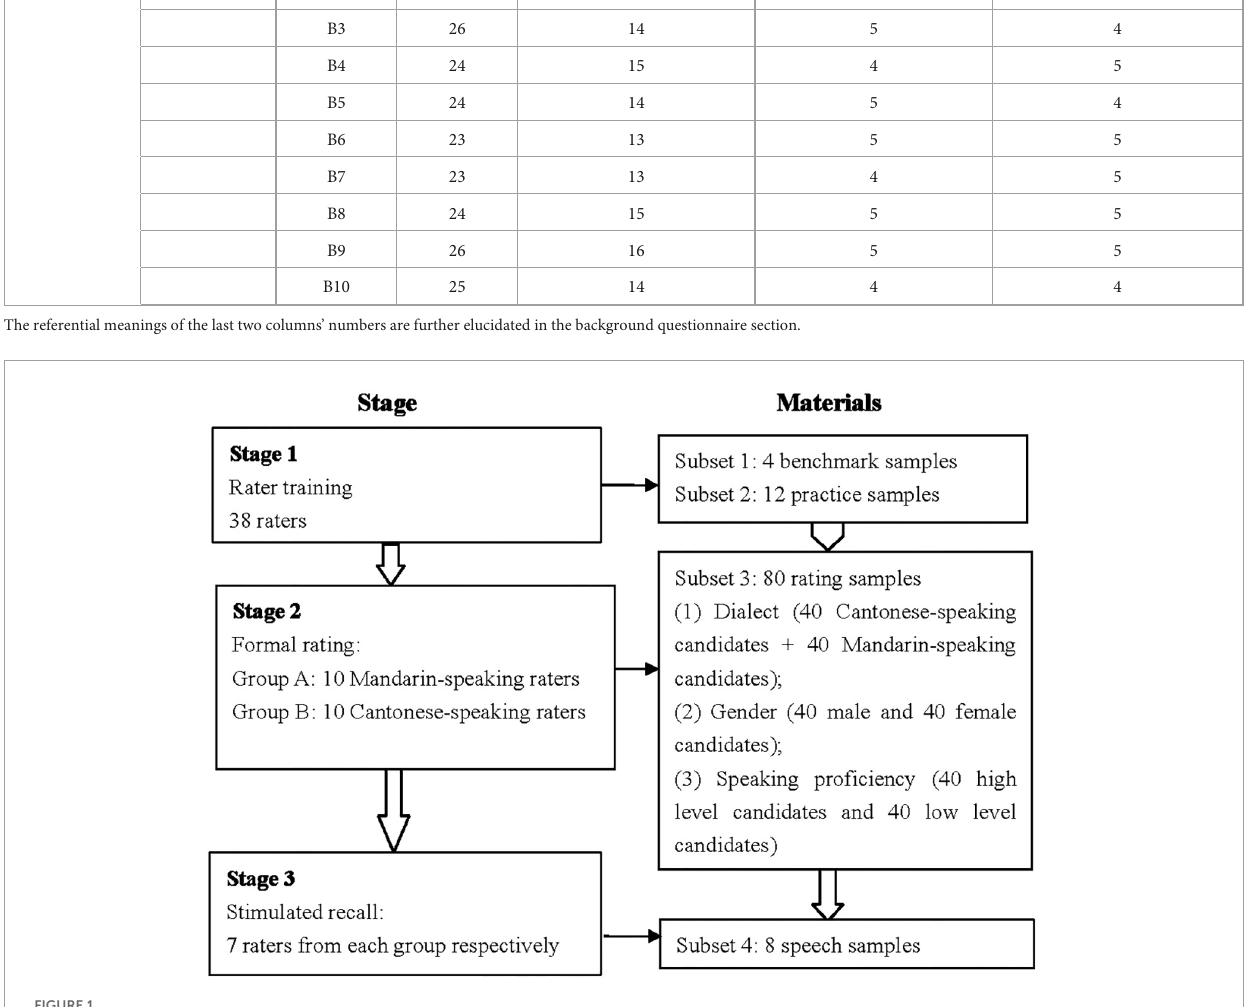
(ANOVA) was performed to examine whether there were any significant differences in the scores of two candidate groups awarded by two rater groups through the software SPSS